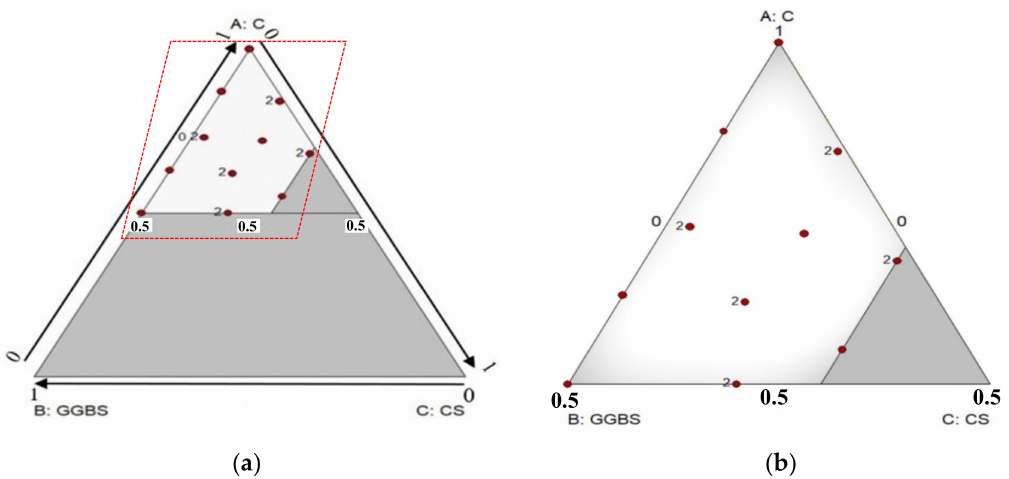
Figure 6. ( a ) Experimental design space; ( b ) experimental points distribution within the experimental design